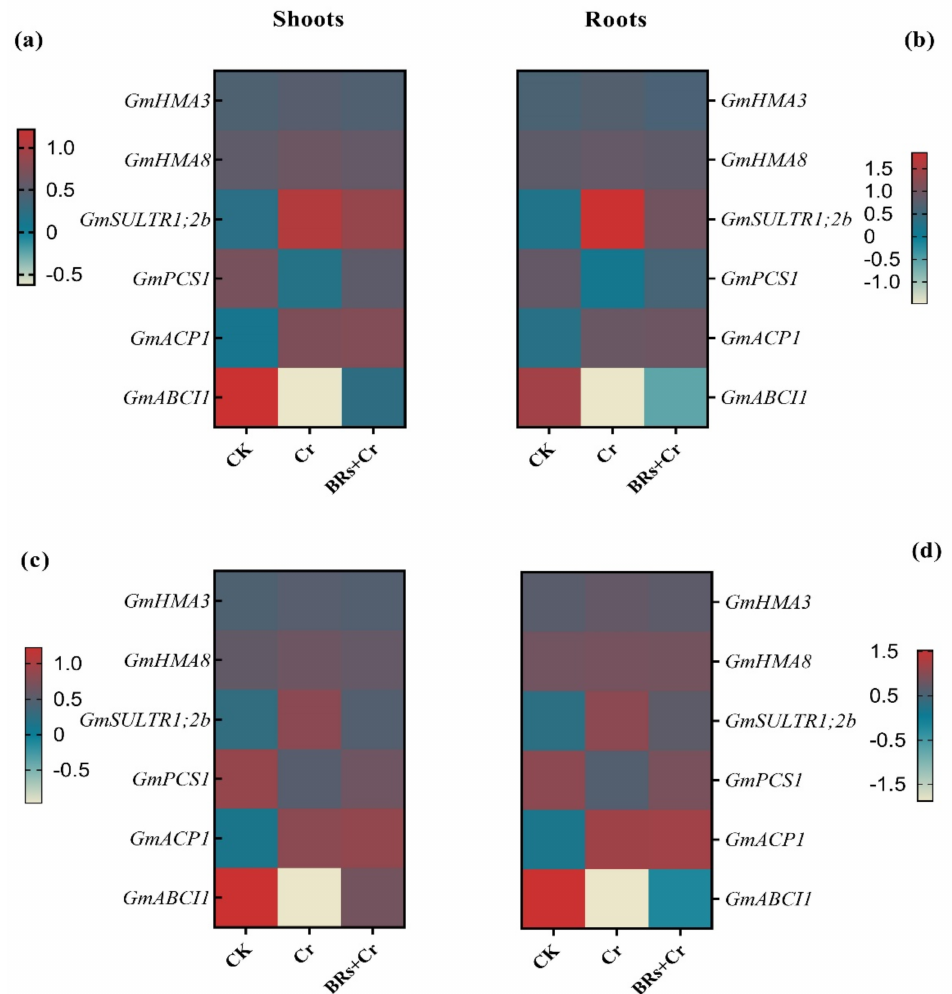
Figure 9. Effect of BRs foliar application on the relative expression of soybean P-type heavy metal AT- Pase (HMA), Sulfate (S) transporters (SULTRs), Phytochelatins (PCs), Acid − Phosphatase − Encoding Gene ( GmACP1 ), and ATP binding cassette transporter (ABC) in ( a ) XD-18 shoots, ( b ) XD-18 roots, ( c ) HD-19 shoots, and ( d ) HD-19 roots of soybean genotypes under chromium (Cr) (0 and 100 µ M) stress. The transcription levels were normalized with Actin ( ACT11 ) in each